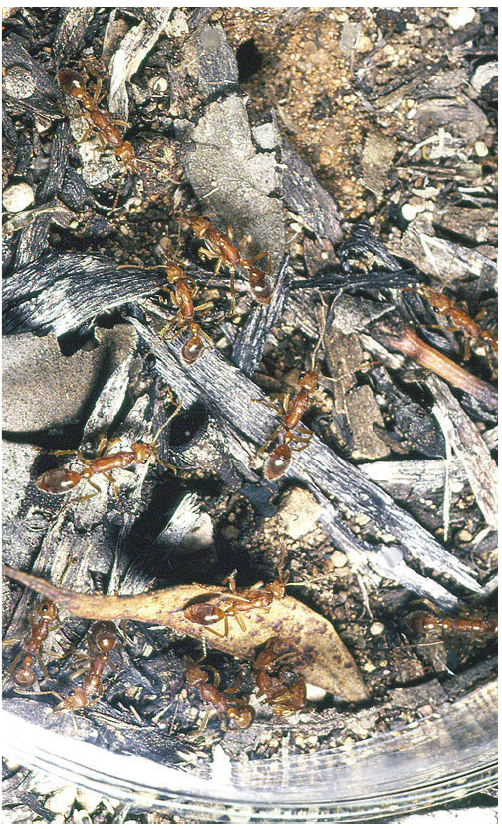
Figure 1: Nothomyrmecia macrops Clark: prospective foragers impounded at dusk under experimental cover dish prior to colour marking. The nest entrance is at the top of the picture (Poochera, SA, nest “yellow,” R. W.